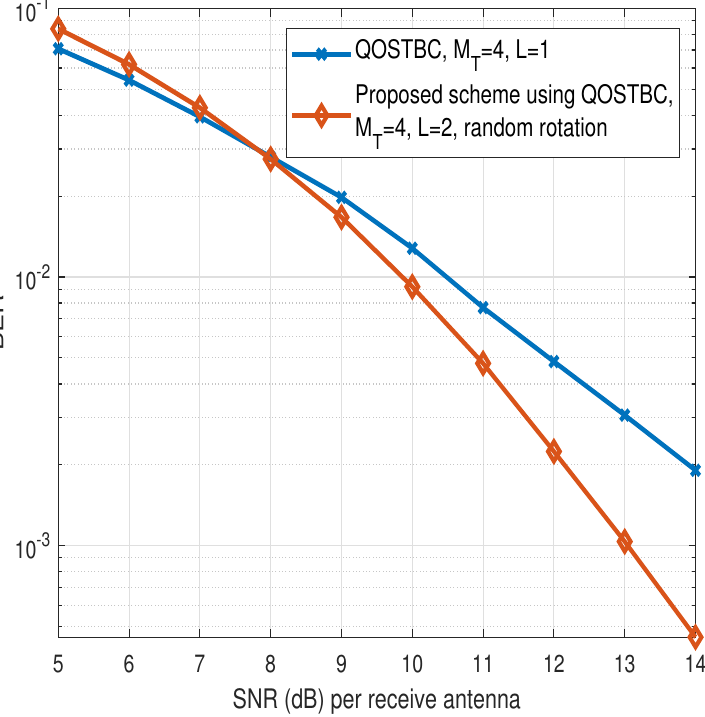
Figure 6. Performance of the proposed scheme based on QPSK − modulated STBC, M T = 4, M R = 1, L = M =